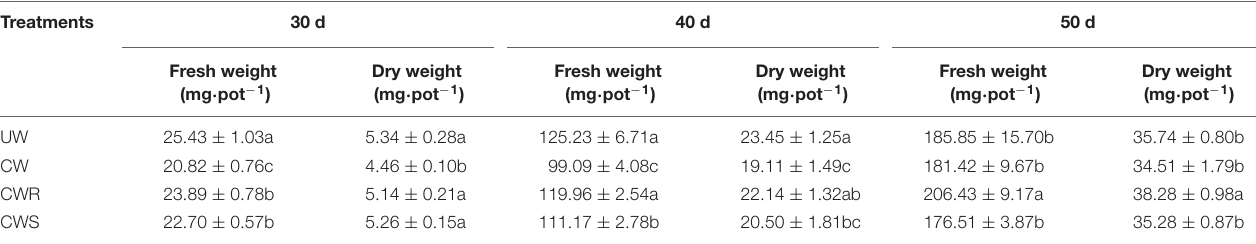
UW, uncontaminated soil planted with white clover; CW, contaminated soil planted with white clover; CWR, contaminated soil planted with white clover and inoculated with strain Phe15 via root irrigation; CWS, contaminated soil planted with white clover and inoculated with strain Phe15 via soaked seed. Different letters in the same column indicate significant differences (P < 0.05).